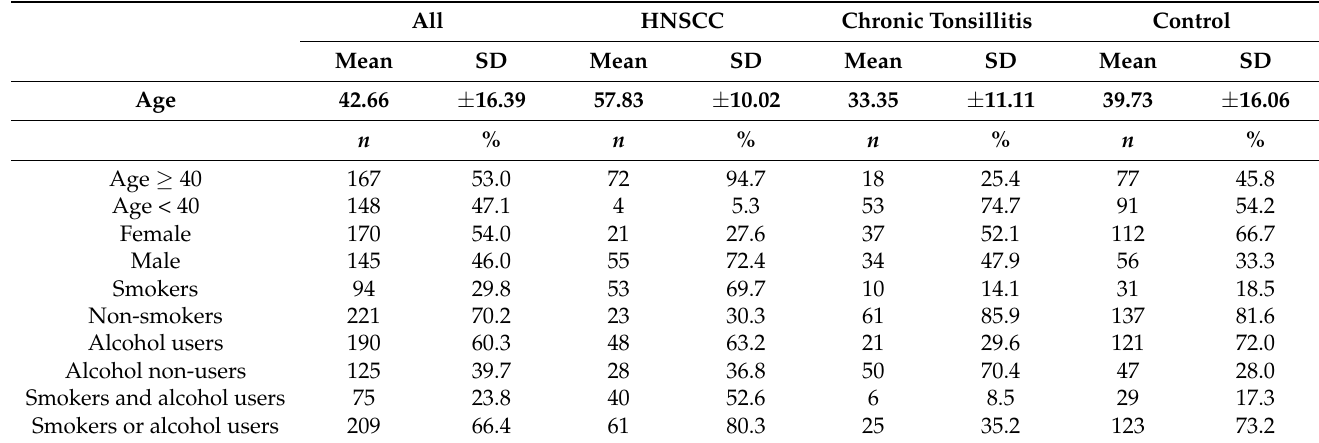
Table 1. Demographic data of the study